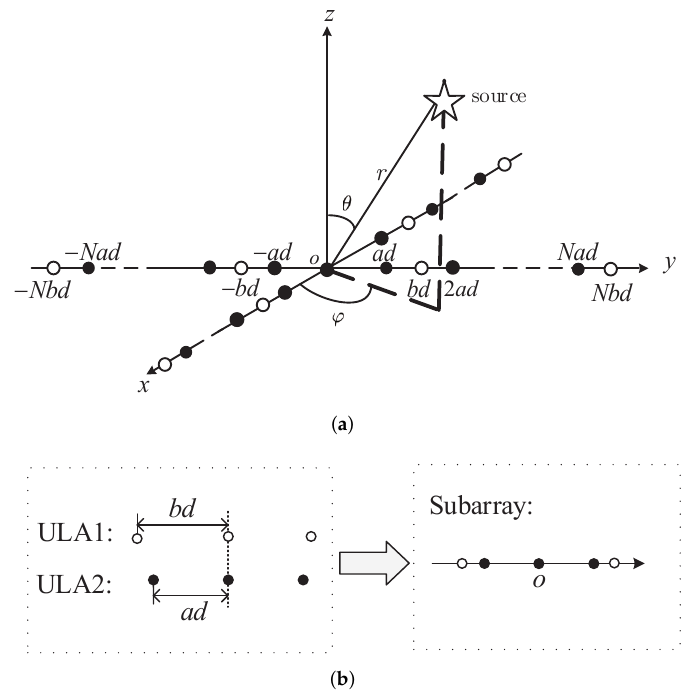
Figure 1. SSCA model. ( a ) SSCA with single source ( b ) Subarray of SSCA in an